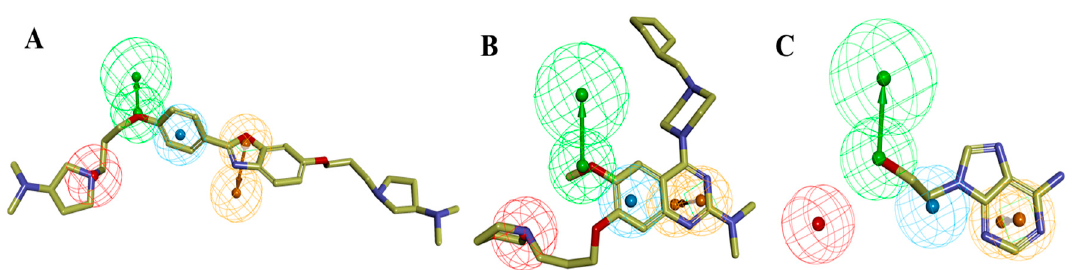
Figure 6. Ligand pharmacophore mapping of training set: ( A ) most active compound 32 (IC 50 : 0.43 μ M), ( B ) most active compound 14 (IC 50 : 0.7 μ M), and ( C ) inactive compound 44 (IC 50 : 684 μ M). The pharmacophoric features HBA, HYA, PI, and RA are signified with green, blue, red, and orange, respectively.